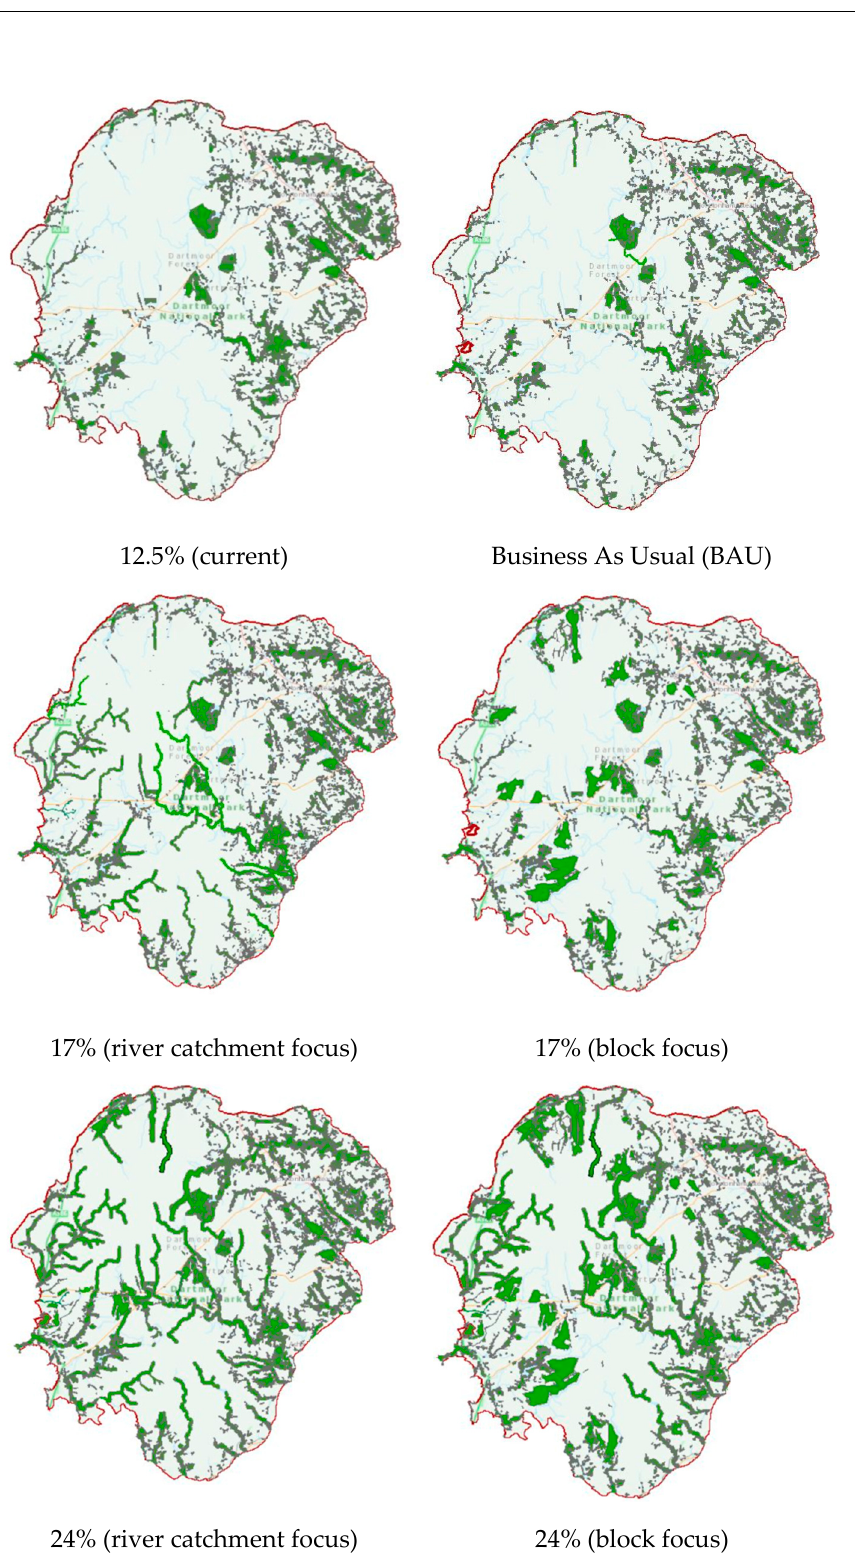
Figure 1. Tree cover maps of the Dartmoor National Park, UK, used to stimulate scenario-related discussion with the stakeholder interviewees. Two patterns of expansion, along river catchments and in contiguous blocks, as well as two target covers were used.